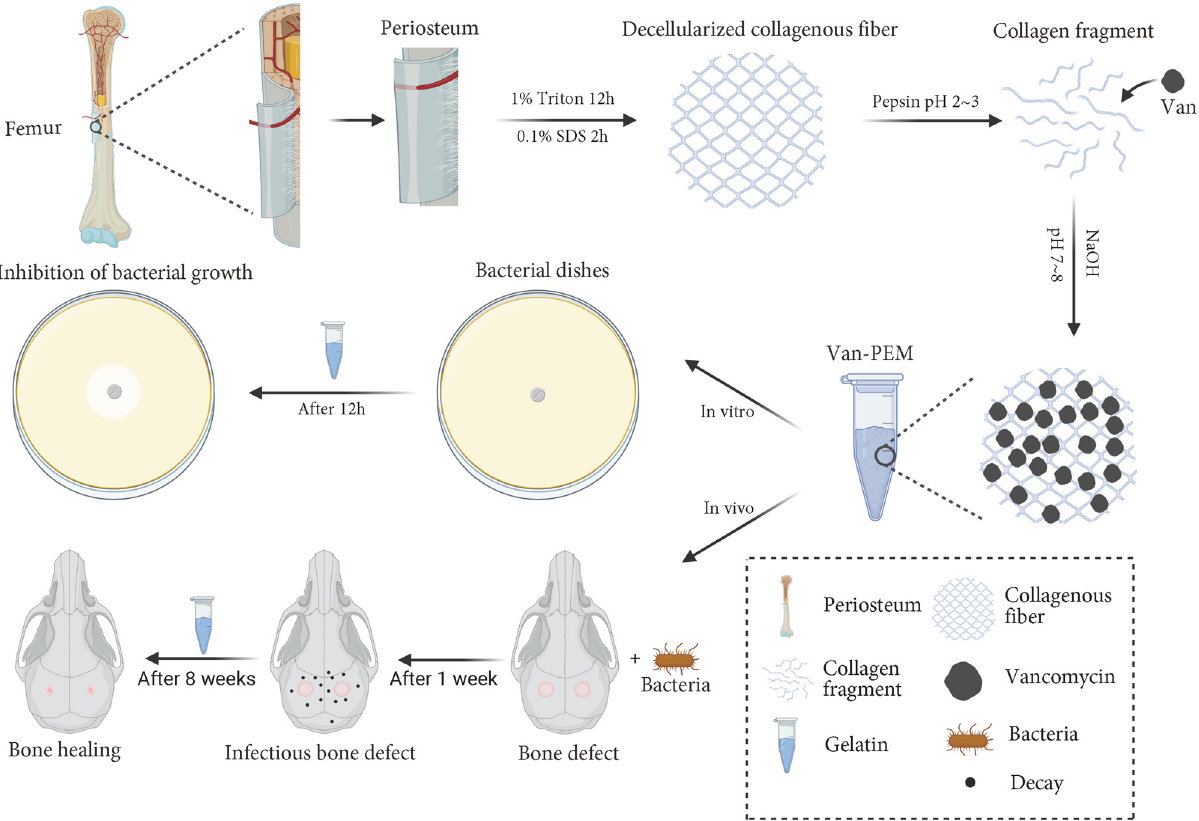
Scheme 1: Schematic showing application of the porcine - acellular - periosteal - matrix hydrogel - encapsulated vancomycin to heal infectious bone